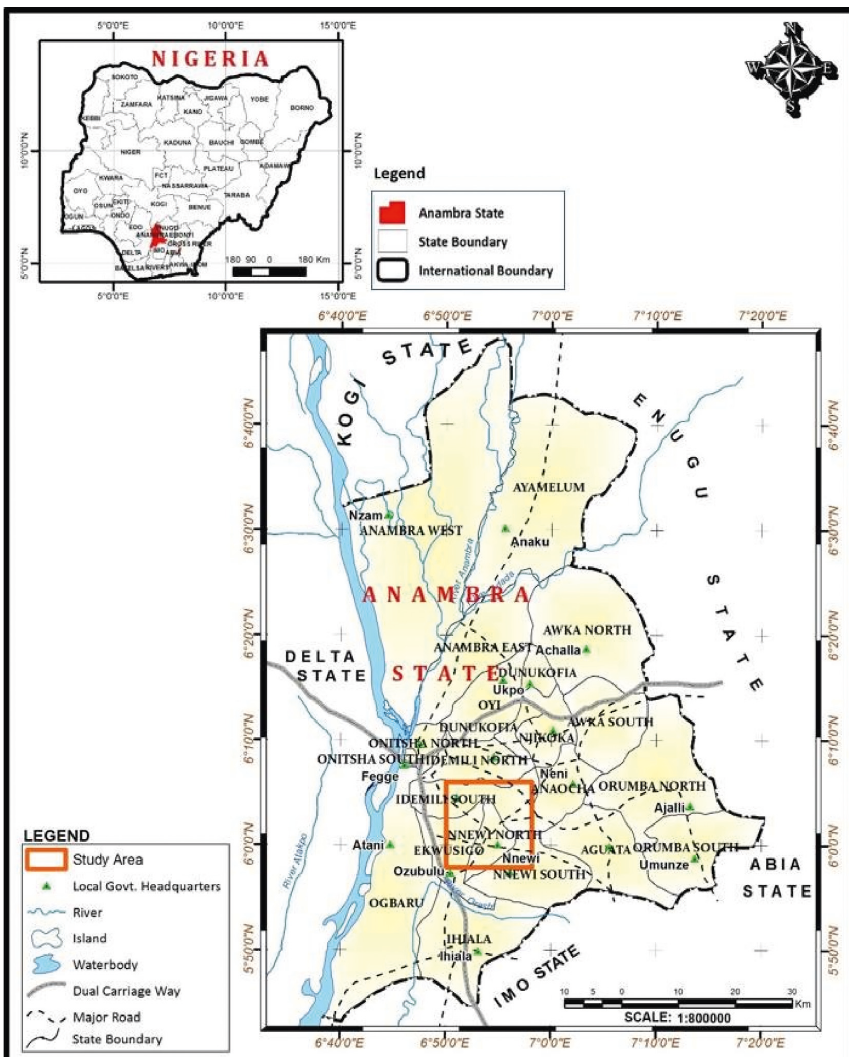
Figure 1: Geographic representation of Nigeria and